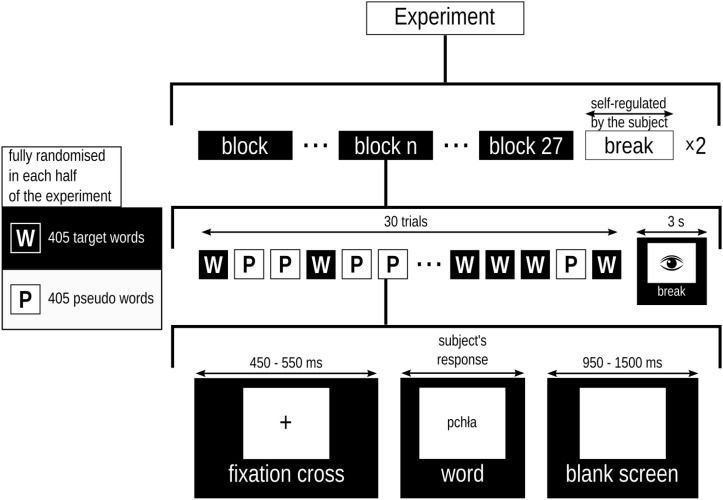
Diagram of the experiment’s protocol.